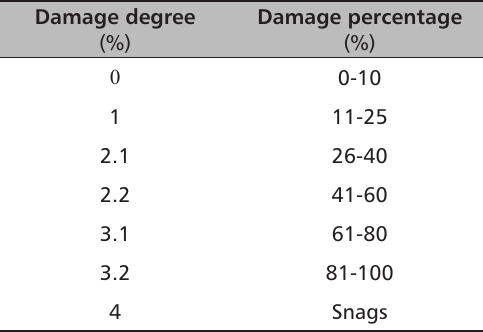
TABLE 1. Damage degree scale Damage